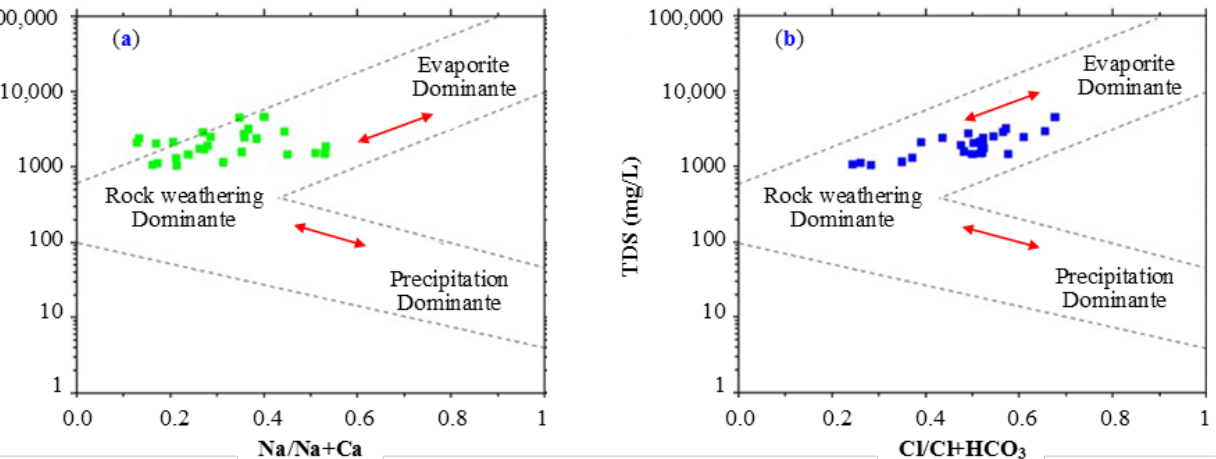
Figure 4. Geochemical controlling mechanisms according to Gibbs diagram: ( a ) TDS vs. Na/Na+Ca, and ( b ) TDS vs. Cl/Cl+HCO 3 .